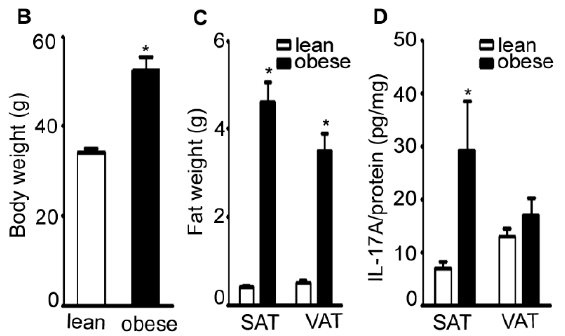
Figure 1. Interleukin-17A (IL-17A) levels are increased in SAT of obese mice. ( A ) Representative pictures of obese mice ( n = 6) fed with a high-fat diet and lean mice ( n = 6) fed with a regular diet at age of 30 weeks; ( B ) animal body weight mean ± SEM (error bars), n = 6 per group, * p < 0.001; ( C ) adipose tissue weight mean ± SEM (error bars), n = 6 per group, * p < 0.001; and ( D ) IL-17A levels (pg/mg tissue protein) in adipose tissues, mean ± SEM (error bars), n = 6 per group, * p < 0.05. SAT: Subcutaneous adipose tissue; VAT: visceral adipose tissue.